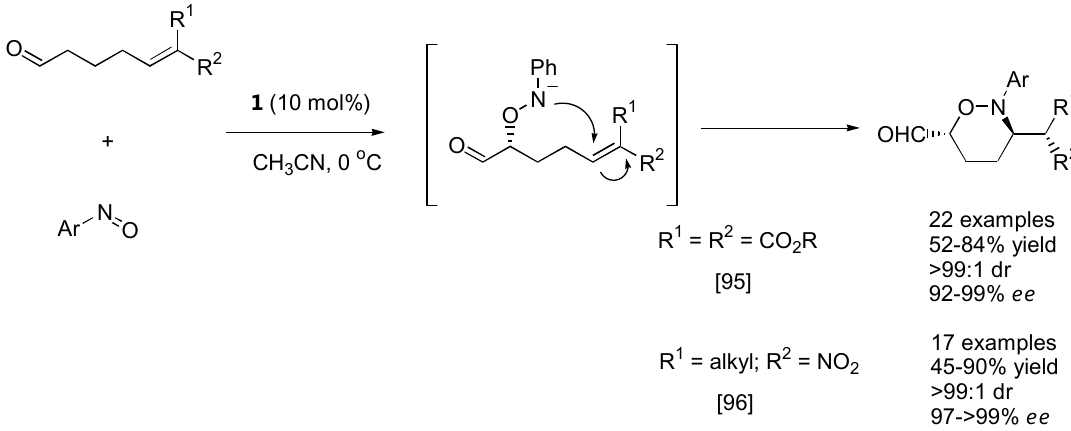
Figure 24. Tandem aminoxylation-intramolecular Michael addition of aminoxylated products derived from unsaturated aldehydes [95,96].